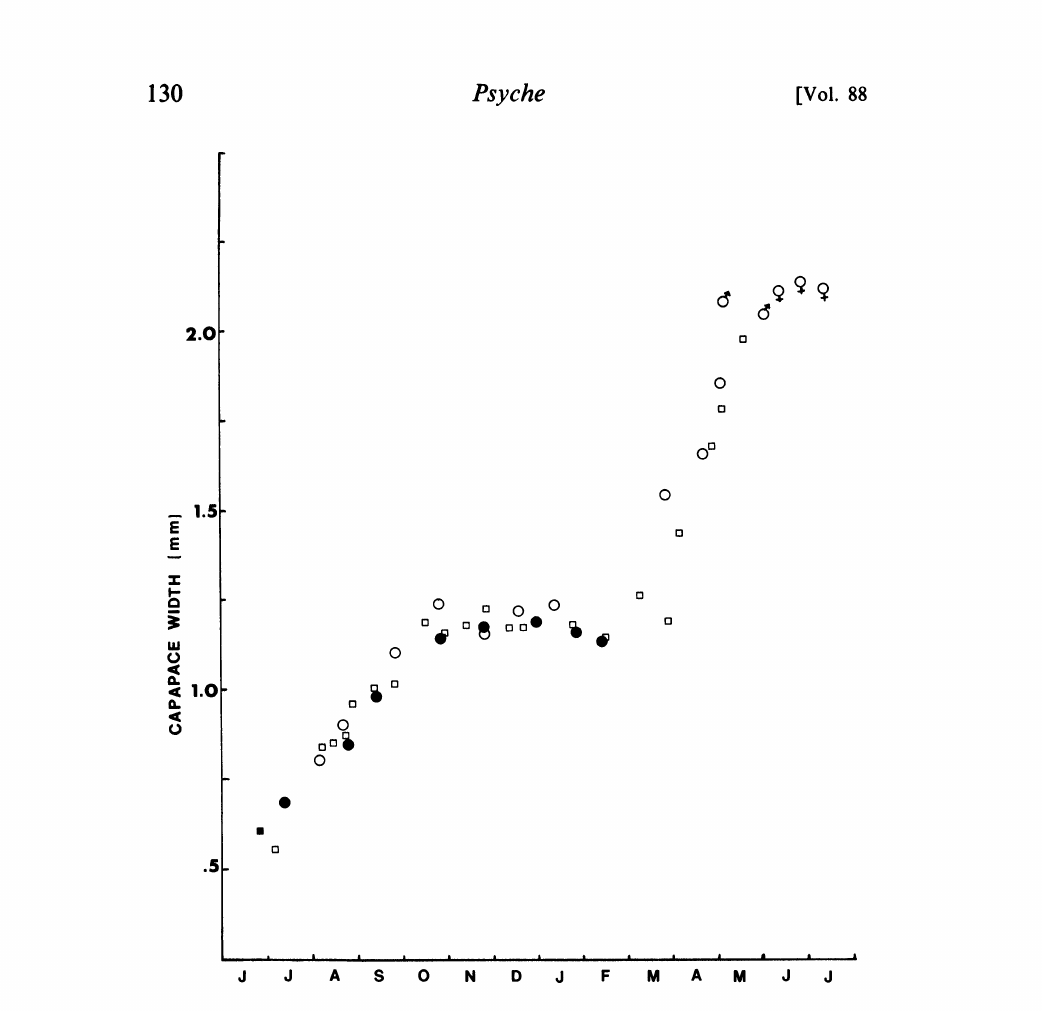
Figure 5. Mean carapace width of immature and adult Lyssomanes viridis (Walckenaer) at Tall Timbers, Leon County, Florida 1971-1973 and 1977-1978. Open circles 1971-1972, closed circles 1972-1973, open squares 1977-1978 closed square (1) 1978 broods. Sex symbols indicate males and females for 1971-1972 and